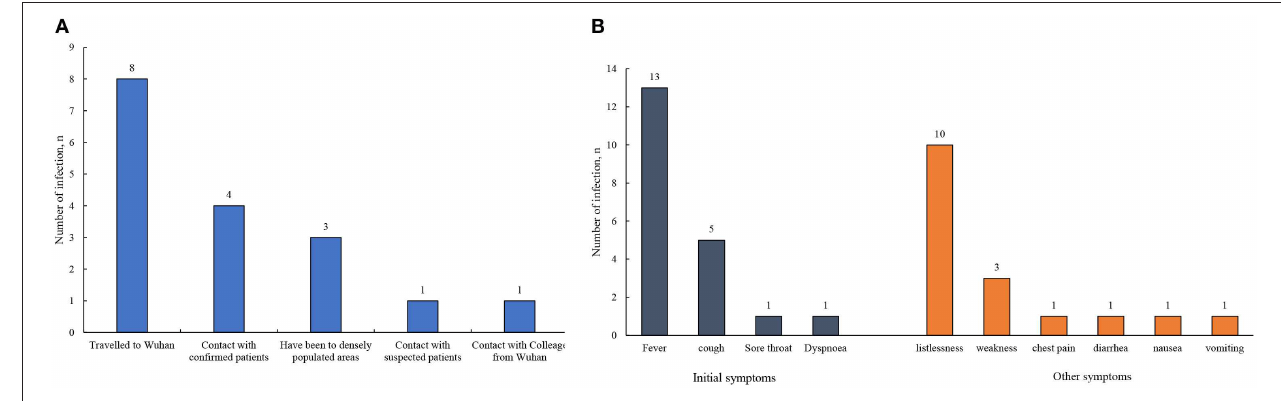
FIGURE 1 | (A,B) The exposure histories and clinical symptoms of the patients with